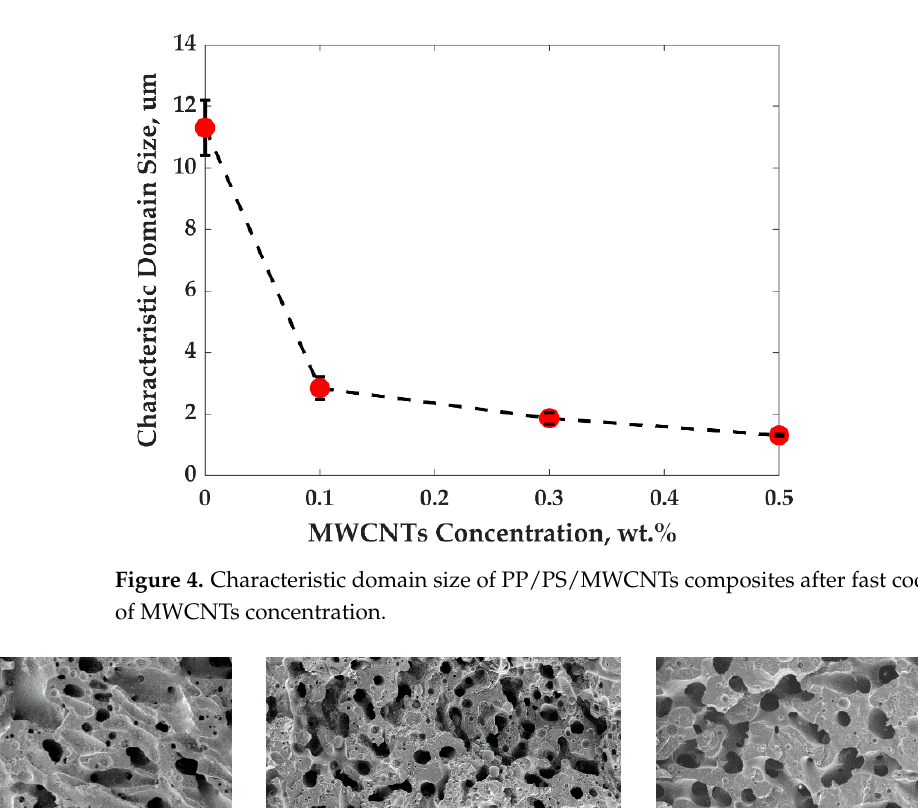
Figure 4. Characteristic domain size of PP/PS/MWCNTs composites after fast cooling as a function of MWCNTs concentration.